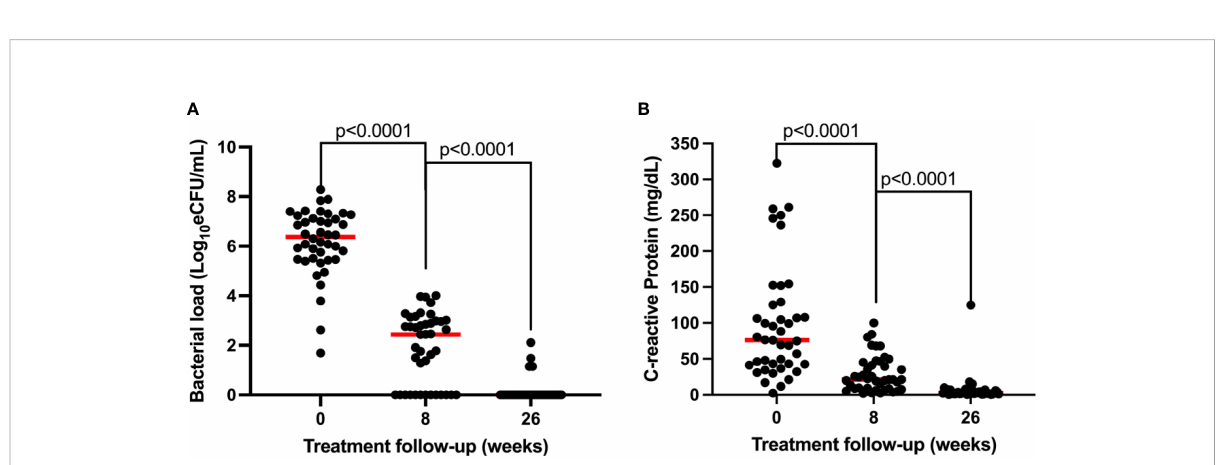
FIGURE 4 Comparison of the resolution of bacillary load measured by TB-MBLA (A) and resolution of blood CRP (B) in response to anti-TB therapy observed in 43 patients. Dots represents individual measurements of the variables before (week 0) and at weeks 8 and 26 of the treatment